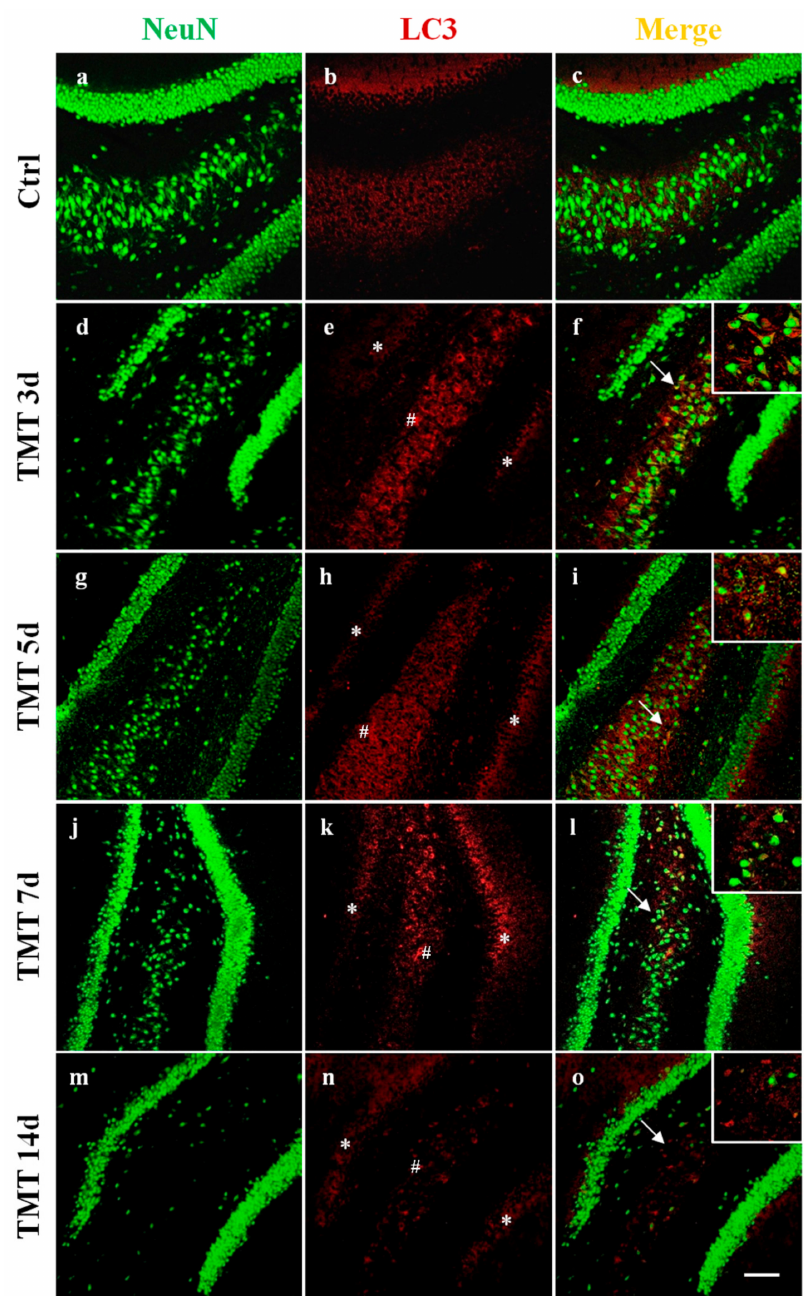
Figure 4. Localization and expression of LC3 in the rat hippocampal neurons, after TMT treatment, in the CA4 area (#) are shown. Sections of the CA4 field at di ff erent intoxication time-points (3, 5, 7, and 14 days) are labeled for Neu N (green, a , d , g , j , m ), LC3 (red, b , e , h , k , n ), and Neu N / LC3 (merge, c , f , i , l , o ). Control sections ( a – c ). At 3 days after treatment, marked LC3 immunoreactivity was observed ( e ) and LC3 labeling strongly increased at 5 days ( h ). LC3 staining decreased at 7 ( k ) and 14 days ( n ) post intoxication. Non-relevant LC3 reactivity in the Dentate Gyrus (*) was observed at any time of treatment ( e , h , k , n ). Note the progressive loss of Neu N-positive neurons in TMT-treated rats ( d , g , j , m ) compared with control rats ( a ). Arrows and inserts show details. Scale bar: 100 µ m. Ctrl: control sample, d: days. For interpretation of the references to color in this figure legend, the reader is referred to the Web version of this